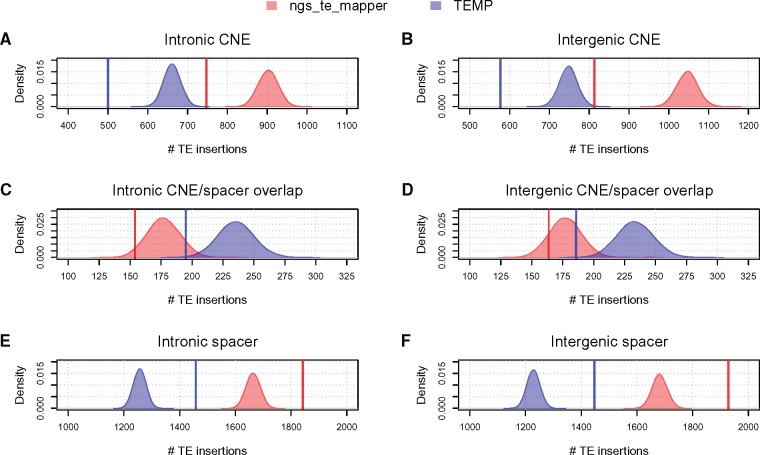
—TEs in normally recombining regions of the Drosophila melanogaster genome are depleted in conserved noncoding elements. Observed numbers of TEs in different noncoding compartments are shown as vertical lines for ngs_te_mapper (red) and TEMP (blue). Empirical null distributions of the numbers of TEs in different noncoding compartments in 10,000 random permutations are shown as density plots for ngs_te_mapper (red) and TEMP (blue). All permutation analyses were restricted to normally recombining regions of the D. melanogaster genome as defined by Cridland et al. (2013). Permutation analyses were conducted across intronic regions only (A, C, and E) or intergenic regions only (B, D, and F). Observed and simulated numbers of TEs were counted in CNEs (A and B), CNE/spacer boundaries (C and D), or spacers (E and F). The TEMP data set has higher number of observed and expected CNE/spacer overlaps (C and D) despite having fewer TE insertions overall because of a larger average TSD length (7.71 bp) relative to ngs_te_mapper (4.73 bp). Observed TEs overlapping intron/exon boundaries or intergenic/exon boundaries were excluded from these analyses. Regions of the reference genome identified by RepeatMasker as TE sequence and any nonreference TE in these regions were also excluded from all permutation analyses.